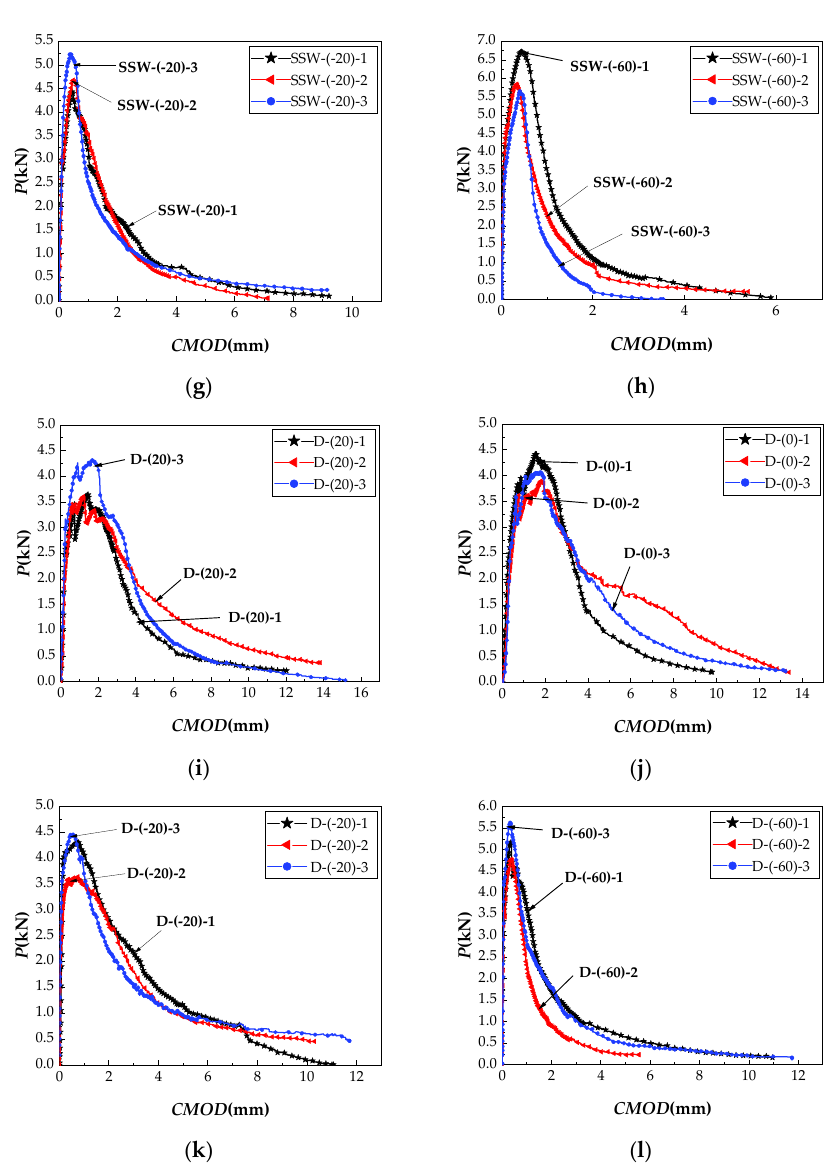
Figure 8. ECC P-CMOD curves of three levels of saturation in four target temperatures. ( a ) SW group at 20 °C; ( b ) SW group at 0 °C; ( c ) SW group at − 20 °C; ( d ) SW group at − 60 °C; ( e ) SSW group at 20 °C; ( f ) SSW group at 0 °C; ( g ) SSW group at − 20 °C; ( h ) SSW group at − 60 °C; ( i ) D group at 20 °C; ( j ) D group at 0 °C; ( k ) D group at − 20 °C; ( l ) D group at − 60 °C. Table 5. ECC fracture properties calculation table, with three levels of saturation in four target tem- peratures. Satura- Tempera- tion Number P ini (kN) tures (°C) Levels